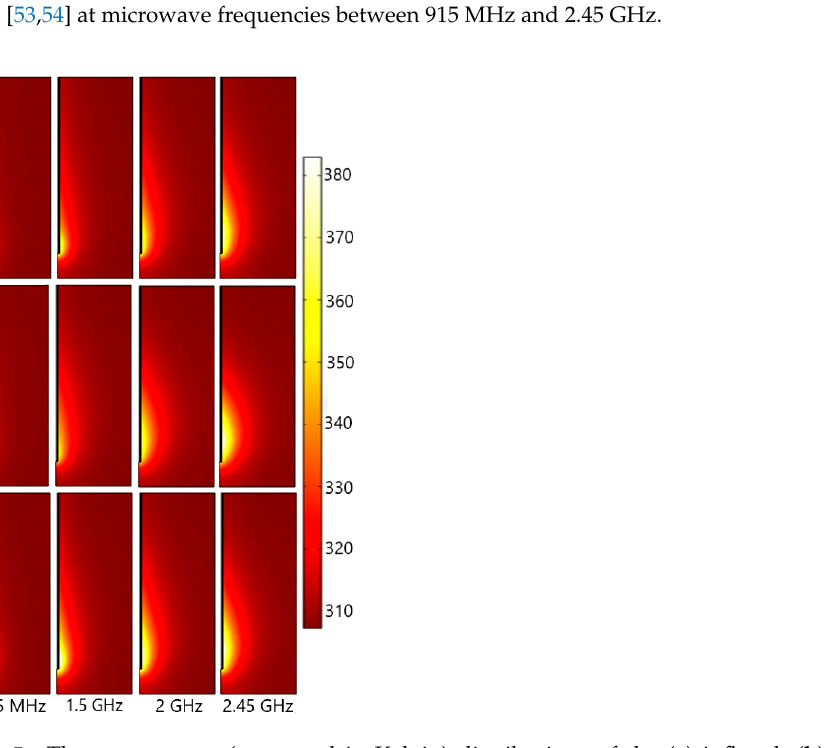
Figure 5. The temperature (expressed in Kelvin) distributions of the ( a ) inflated, ( b ) deflated lungs [52], and ( c ) tissues with constant dielectric properties [53,54] exposed to microwave frequencies from 915 MHz to 2.45 GHz.